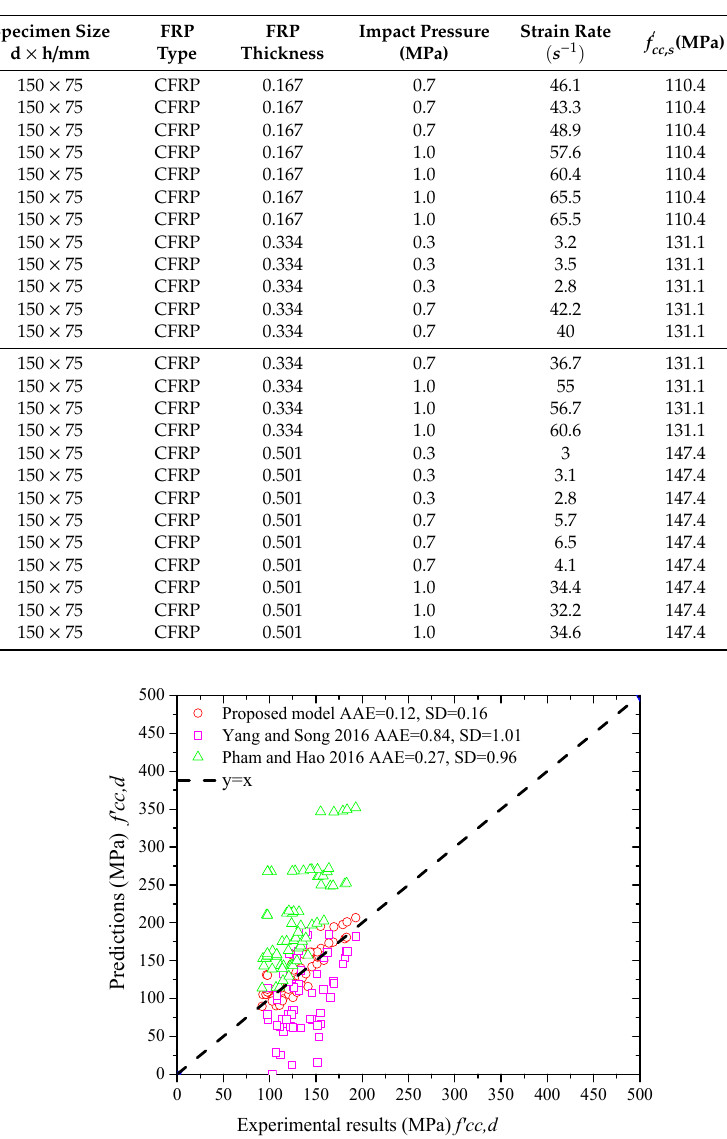
Figure 14. Experimental and predicted values of dynamic compressive strength of FCHC.